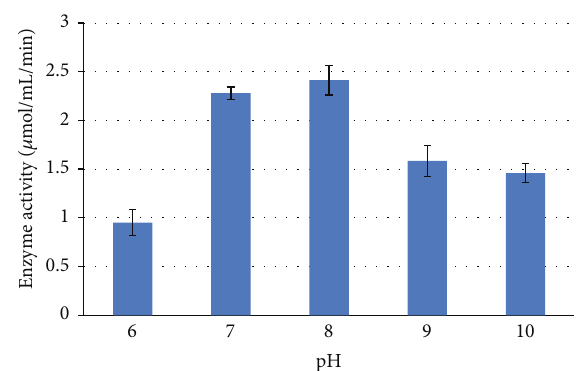
Figure 3: Effect of initial pH levels of the medium on production of L-asparaginase by Streptomyces